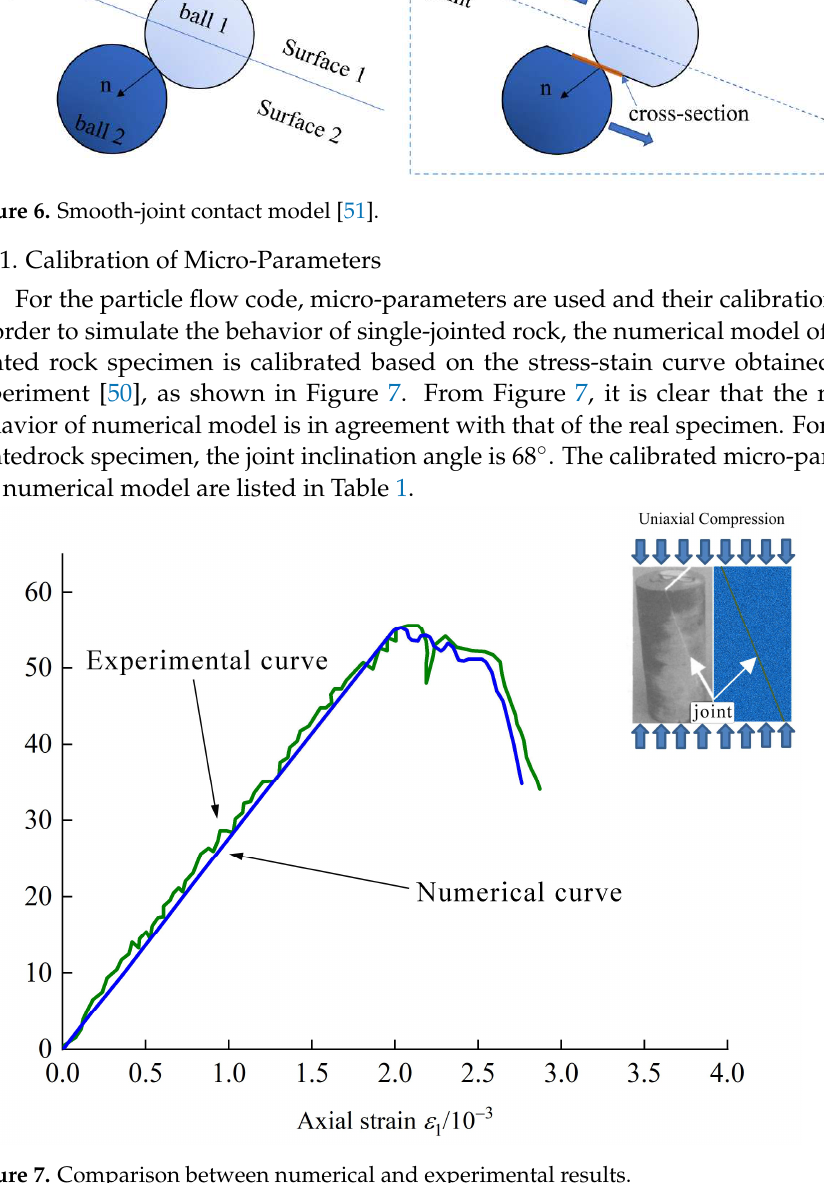
Figure 7. Comparison between numerical and experimental results. Table 1. Micro-parameters of the numerical model.